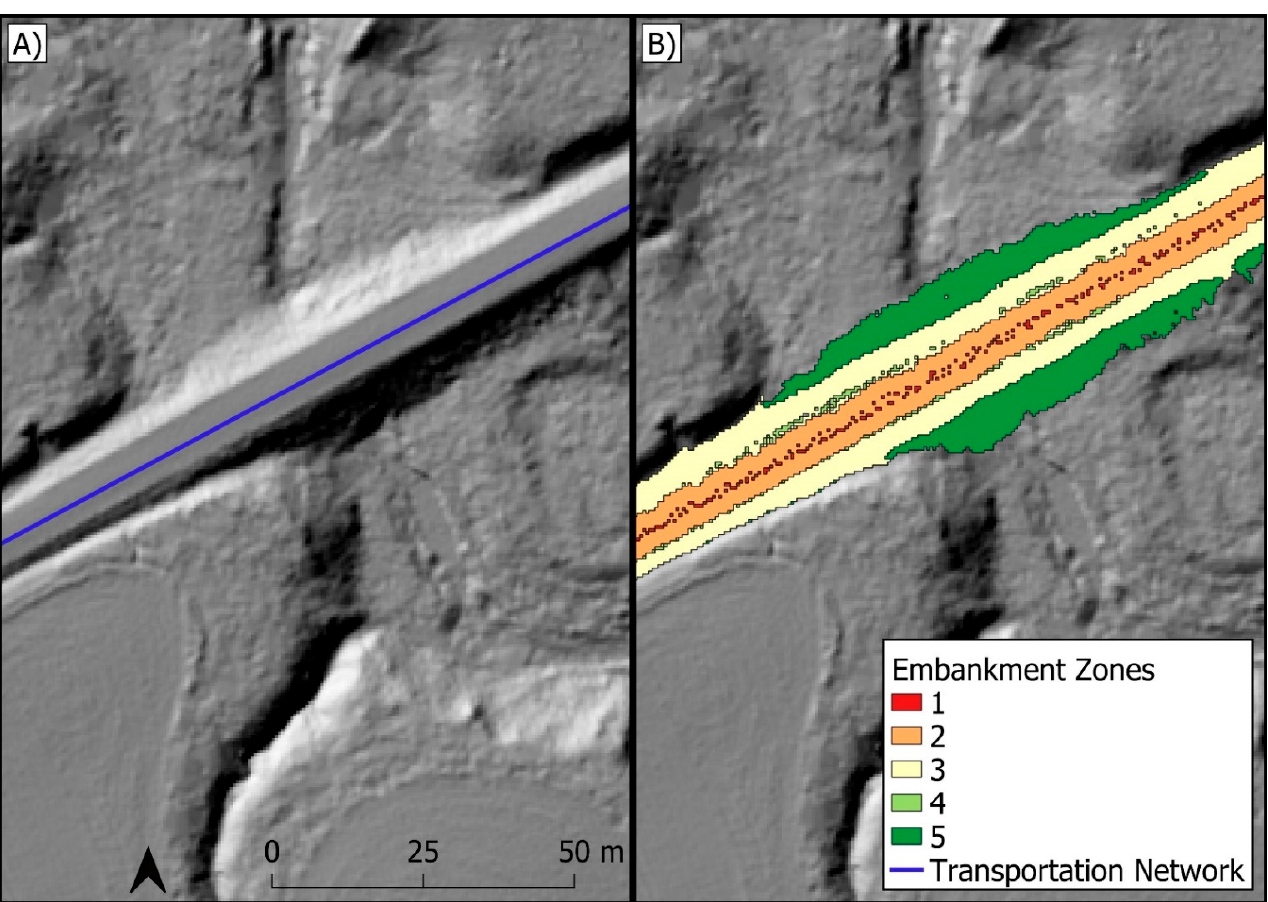
Figure 6. ( A ) An embankment at a valley crossing; ( B ) The embankment at a valley crossing identified by the mapping. Zone 5 cells (dark green) correspond to the sides of embankment at a valley crossing as predicted by the zonal model of embankments.